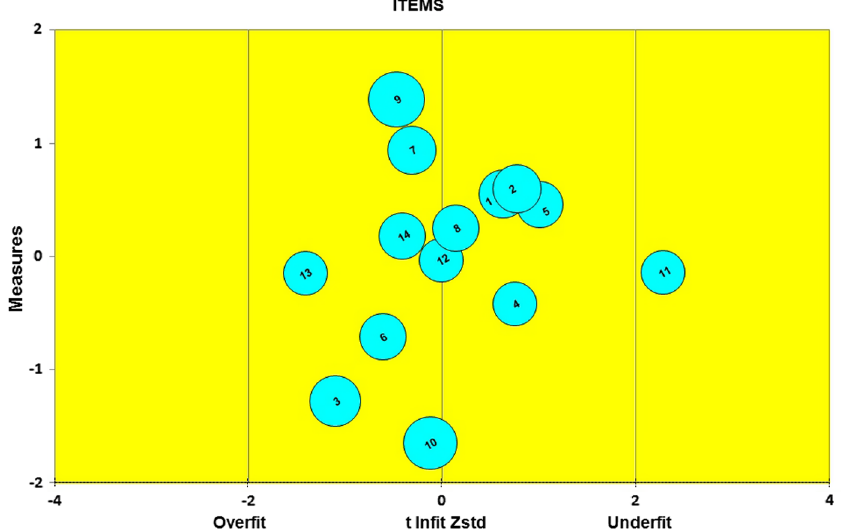
FIG. 3. An example of a bubble chart for 14 test items, plotted from Winsteps [26]. Each bubble represents an item, whose size is proportional to the standard error of item difficulty calibration. Well-fitting items are close to the central vertical line. Item 11 is outside the acceptable range of misfit (infit ZSTD greater than